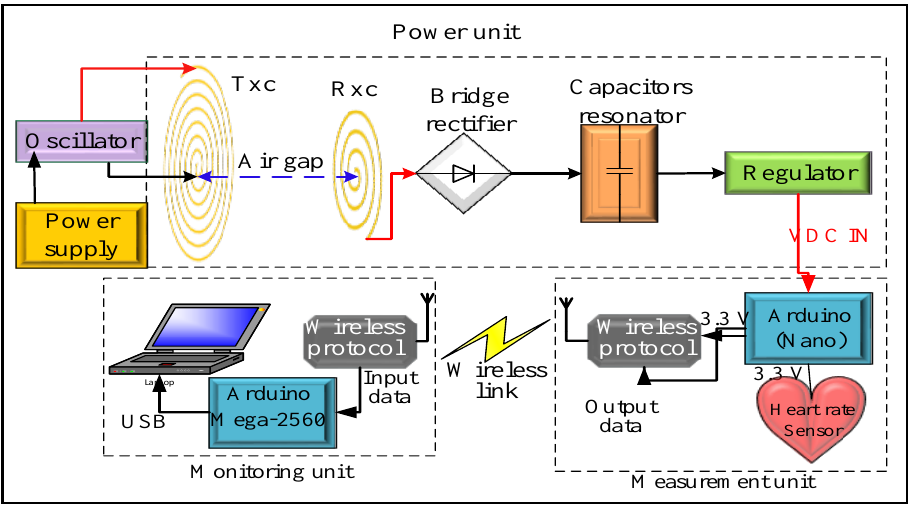
Figure 1. Block diagram of the use of a magnetic resonator coupling (MRC) for a heart rate